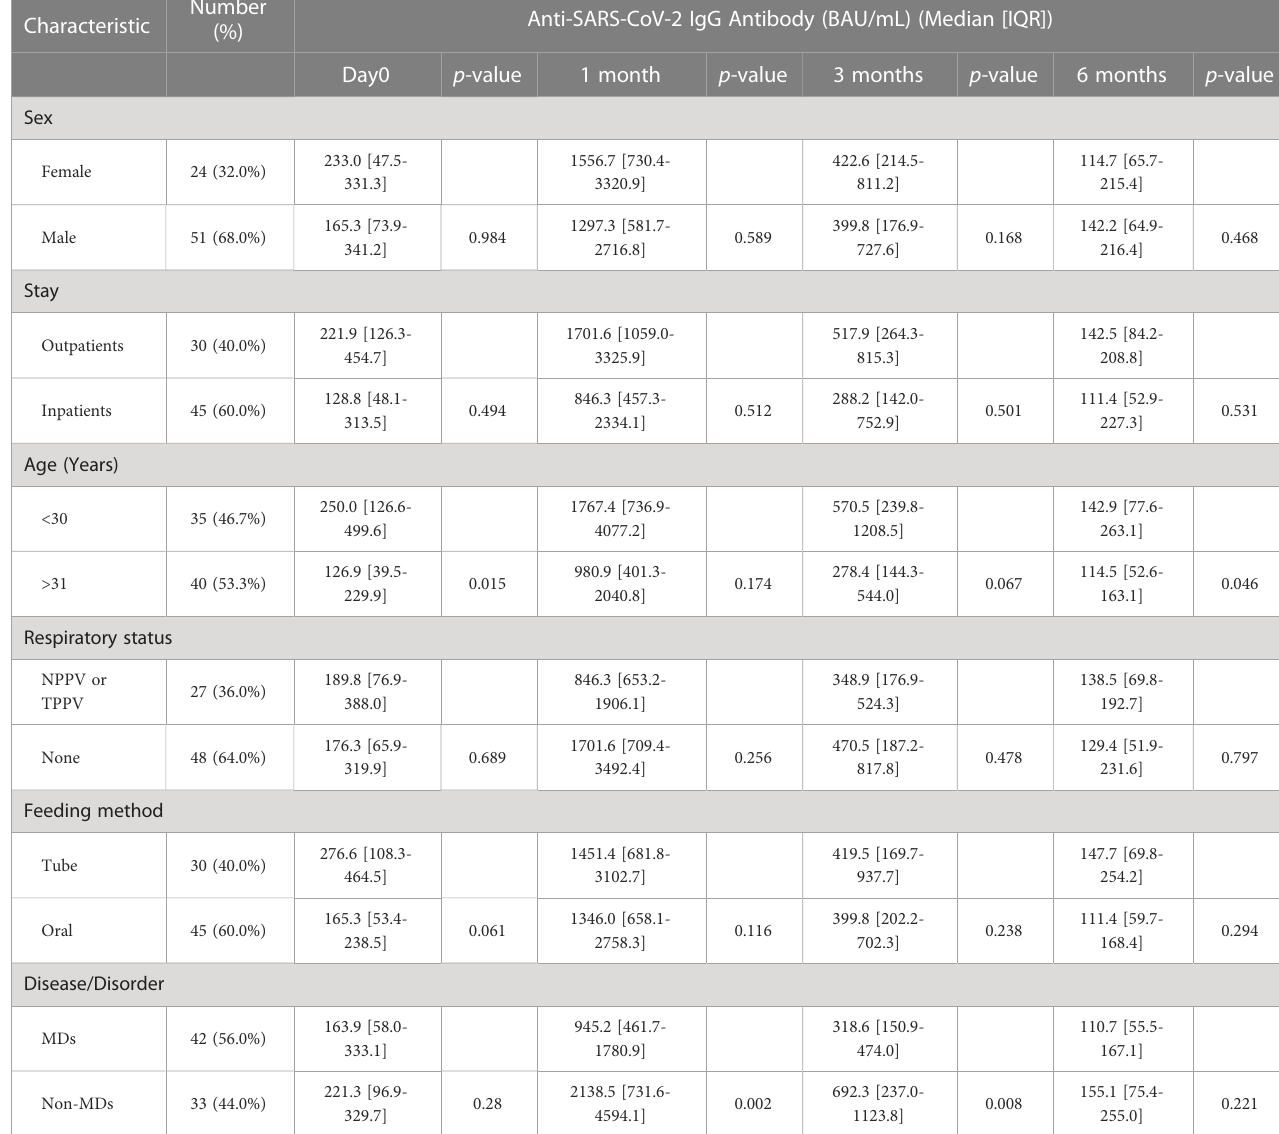
TABLE 1 Comparative results of anti-SARS-CoV-2 IgG antibody levels in each characteristics.